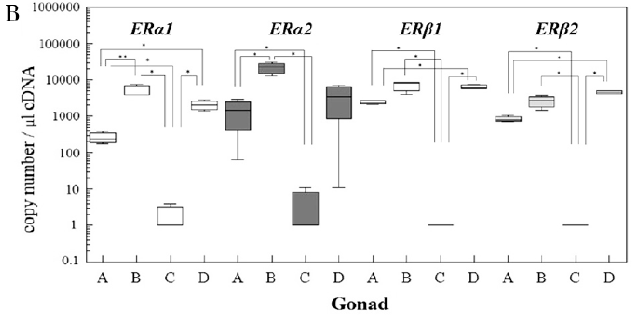
Figure 5. ( A ): The mRNA expression levels of the four ER isoforms in the liver, head kidney (HK), immune cells isolated from head kidney or from blood during the reproductive cycle. The reproductive cycle was subdivided into four stages: stage A = start of reproductive cycle, stage B = vitellogenic stage, stage C = spawning stage, stage D = post-spawning stage (see Figure 4). The gene copy number of each isoform gene per 1 µL cDNA is presented by Box-Whisker plots (group A: n = 4, B: n = 5, C: n = 3, D: n = 4). Note logarithmic scale of y-axis. * p < 0.05, ** p < 0.01. ( B ): The mRNA expression levels of the four ER isoforms in the ovaries during the reproductive cycle. Table 2. Correlation coefficients ( r 2 ) between serum E2 concentrations and ER mRNA abundance in liver and leukocytes of female rainbow trout over the reproductive cycle. ER